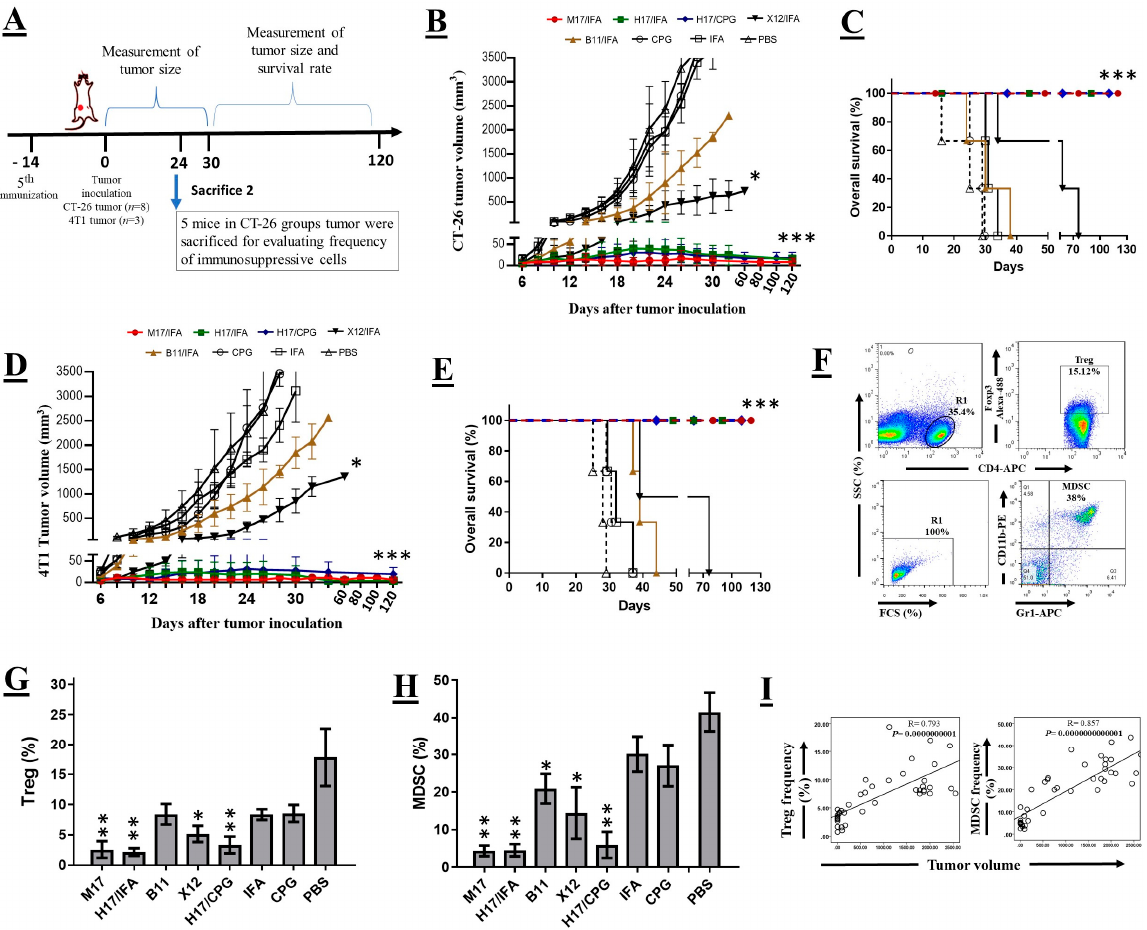
Figure 3. Protective efficacy of fusion proteins. ( A ) The experimental design for tumor challenge. ( B ) The growth curve of the CT26-ROR1 tumor after tumor challenge. ( C ) Kaplan–Meier survival curves of mice in each group after CT26-ROR1 tumor challenge. ( D ) The growth curve of the 4T1-ROR1 tumor. ( E ) Kaplan–Meier survival curves of mice in each group after 4T1-ROR1 tumor challenge. ( F ) Representative dot plots demonstrating the analyzing method used for enumeration of MDSC (below panel) and Treg (top panel). ( G ) Frequencies of MDSC and ( H ) Treg cells in the spleen of each group. ( I ) Correlation of Treg (left) and MDSC (right) frequencies with tumor volume. The results represent mean ± SD. The p values were calculated in comparison to the control adjuvant group (* p < 0.05, ** p < 0.01, and *** p <